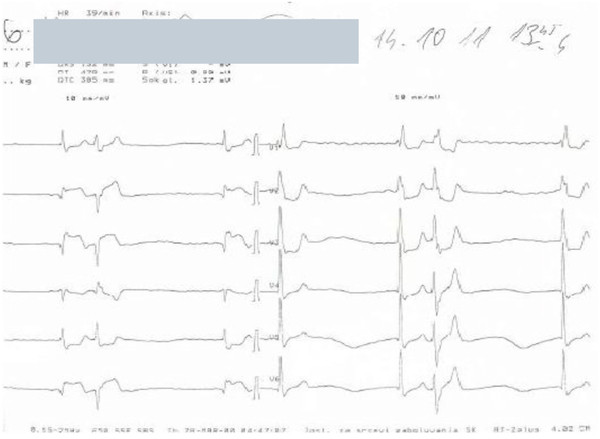
ECG upon admission.